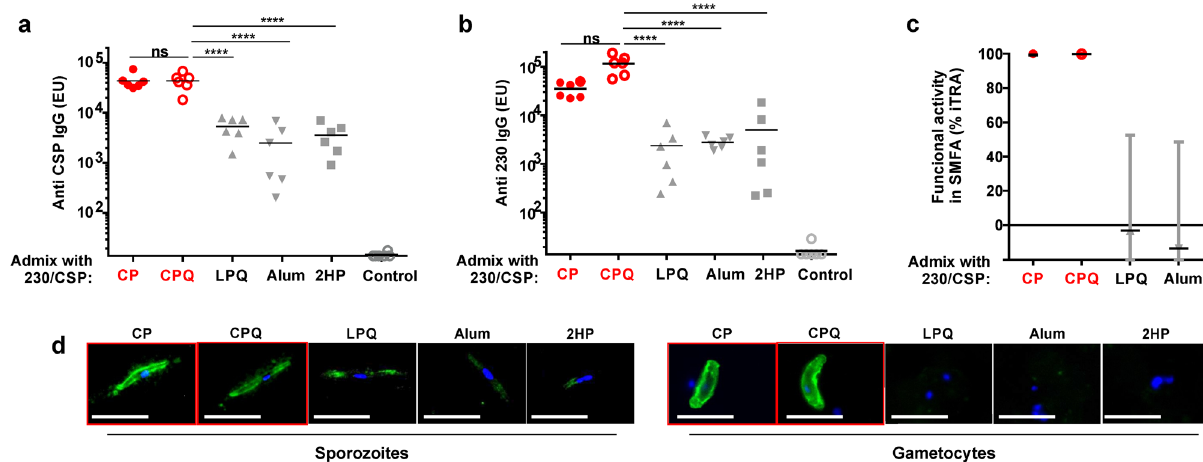
Fig. 5 Bivalent CSP and Pfs230D1 + immunization of inbred mice. C57BL/6 mice ( n = 6 per group) were immunized with 100 ng CSP and 50 ng 230, admixed with indicated adjuvants on day 0 and 21. Sera were collected on day 42, and anti-CSP ( a ) and anti-230D1 ( b ) IgG levels were assessed by ELISA. One-way ANOVA followed by Tukey test using log-transformed data was used to compare statistical differences for the CSP/230/CPQ group versus other groups. **** p < 0.0001. Full statistical analysis is reported in Supplementary Table S4. Bars represent geometric means. c ) SMFA results of puri fi ed IgGs tested at 750 μ g/ml with complement. % Inhibition (TRA) and 95% con fi dence intervals are shown. d Immuno fl uorescence assay of NF54 parasites at sporozoite and gametocyte stages. Bar: 10 µ m. Red symbols or outlines indicate bivalent, liposome-displayed